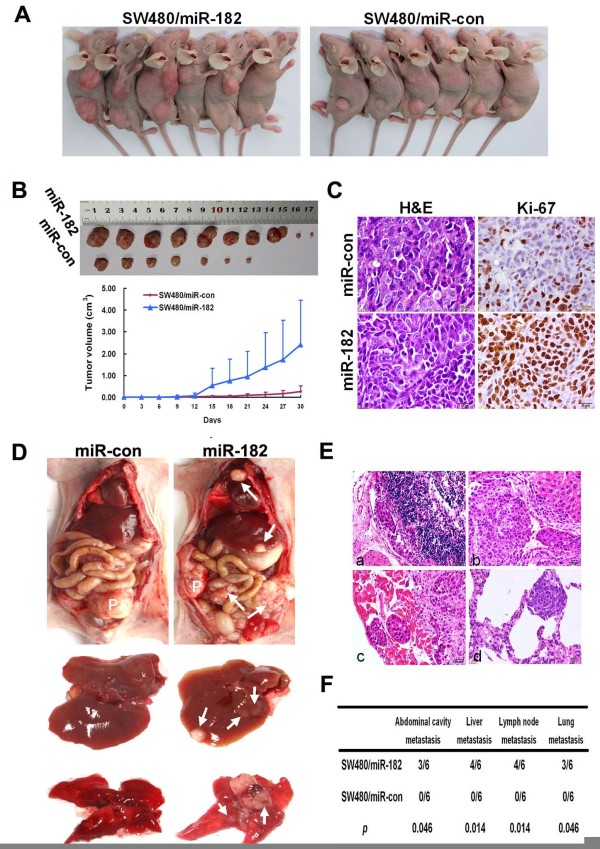
miR-182 facilitated tumor growth, invasion and metastasis in vivo. (A) SW480 cells were infected with pLV-miR-182 or empty vector virus and injected subcutaneously into nude mice. At 30 days after subcutaneous injection, SW480/miR-182 and SW480/miR-con cells produced primary tumors. (B) Representative figure of tumor formed (upper) and growth curve of tumor volumes (lower). Each data point represented the mean ± SD. (C) Representative photographs of H&E and immunohistochemical staining for Ki-67 antibody of primary cancer tissues. (D) The whole-body images of metastasis in nude mice. P denotes primary tumor. White arrows point to the metastatic nodules. (E) Histological images of invasion and metastatic nodules in organs. (a) metastasis of lymph node; (b) metastasis of liver; (c) metastasis of lung; (d) seeding metastasis of abdominal wall. (F) Incidence of metastasis in mice that were implanted with SW480/miR-182 or miR-con cells.